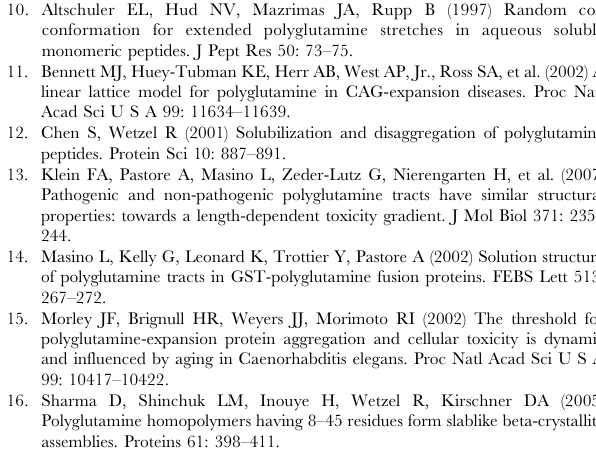
Figure S2 Correlation between pathogenic allele size deter- mined by clone sequencing with Subjects # 7, 8 and 23 highlighted. Patients with a single interrupted pathogenic clone amongst a population of uninterrupted clones are shown in red. They are indistinguishable from patients with pure uninterrupted alleles of the same size. For further details on the correlation, please refer to Figure 1B . Table S1 Frequency with which each clone sequence was detected for each individual. The bold line indicates the pathogenic threshold of $ 39 repeats. Individual # 36 ( + ) is affected with SCA3, but has a borderline interrupted expansion in SCA1. The majority of uninterrupted clones have a size above the pathogenic threshold, whilst the majority of interrupted clones lie below the pathogenic threshold. Table S2 Frequency with which each clone sequence was detected for each individual, corrected for the clone depth sequenced for each patient. The bold line indicates the pathogenic threshold of $ 39 repeats. The number of clones for each patient were expressed as a percentage and these were taken into account when expressing the overall percentage of each clone within the clone population (final column). Table S3 Summary of age at disease onset and allele size data for each patient. This data was used to compile the graphs in Figure 1